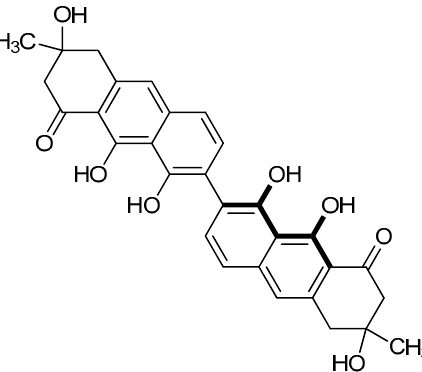
Figure 3. Chemical structure of Isoperoxisomicines.